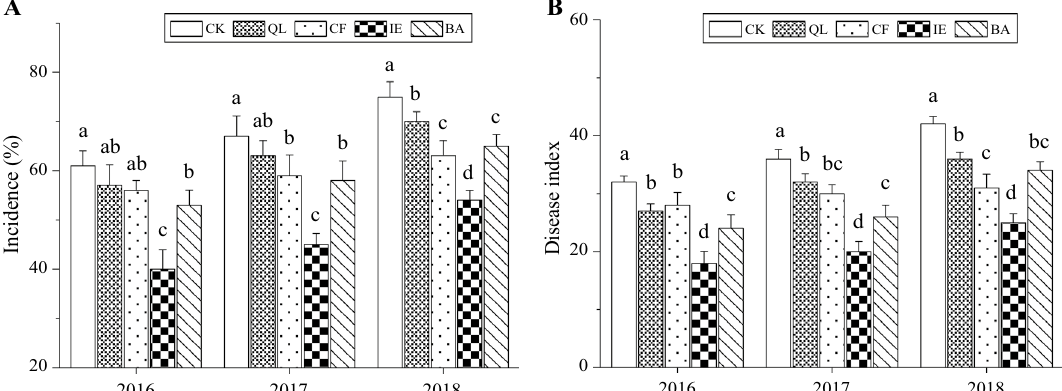
Figure 1. Effects of different treatments on the incidence ( A ) and disease index ( B ) of continuous cropping lily leaf blight. Bars indicate standard error (n = 3). Different letters above columns within the same species indicate significance at p < 0.05 according to Duncan’s test. CK blank control, QL quicklime, CF chemical fungicide, IE inoculation with earthworms, BA biocontrol